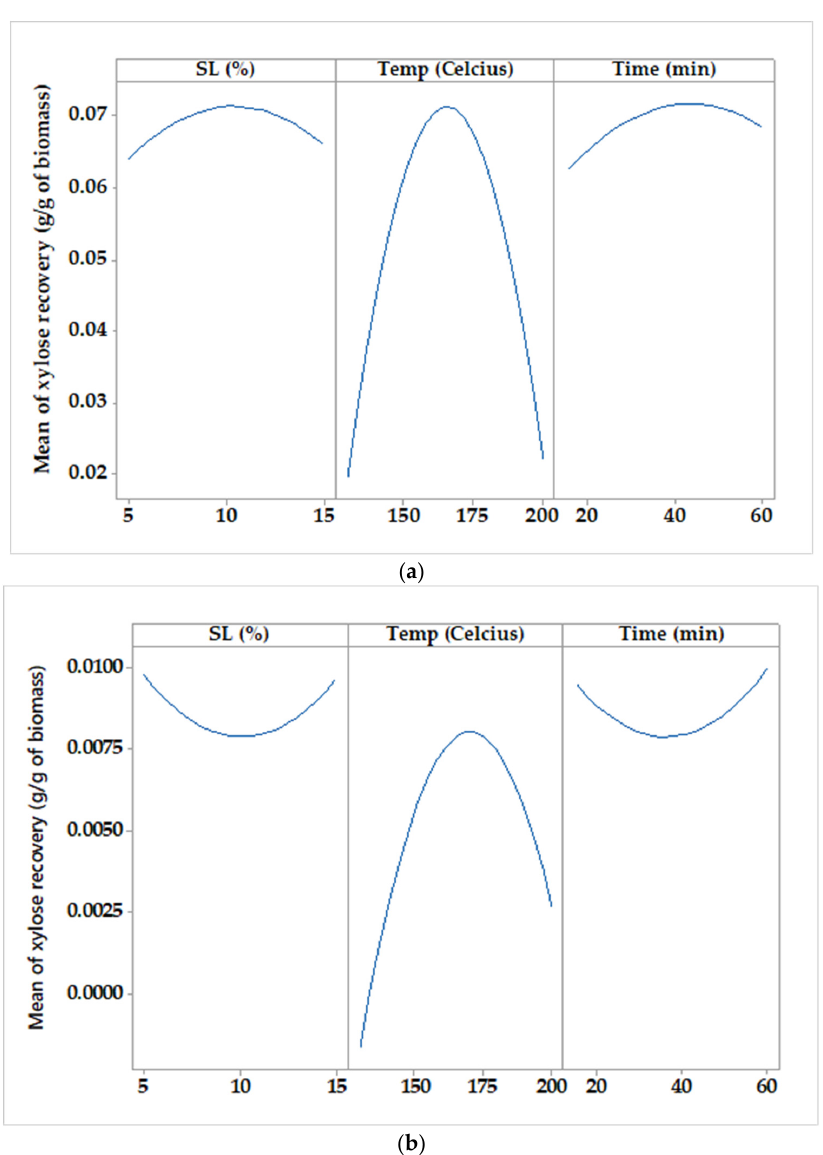
Figure 1. The factorial plot of the main e ff ects of solid loading (SL), temperature, and pretreatment time on ( a ) xylose recovery in solid pretreated oil palm empty fruit bunch (OPEFB) hydrolysate and ( b ) xylose recovery in liquid pretreated OPEFB